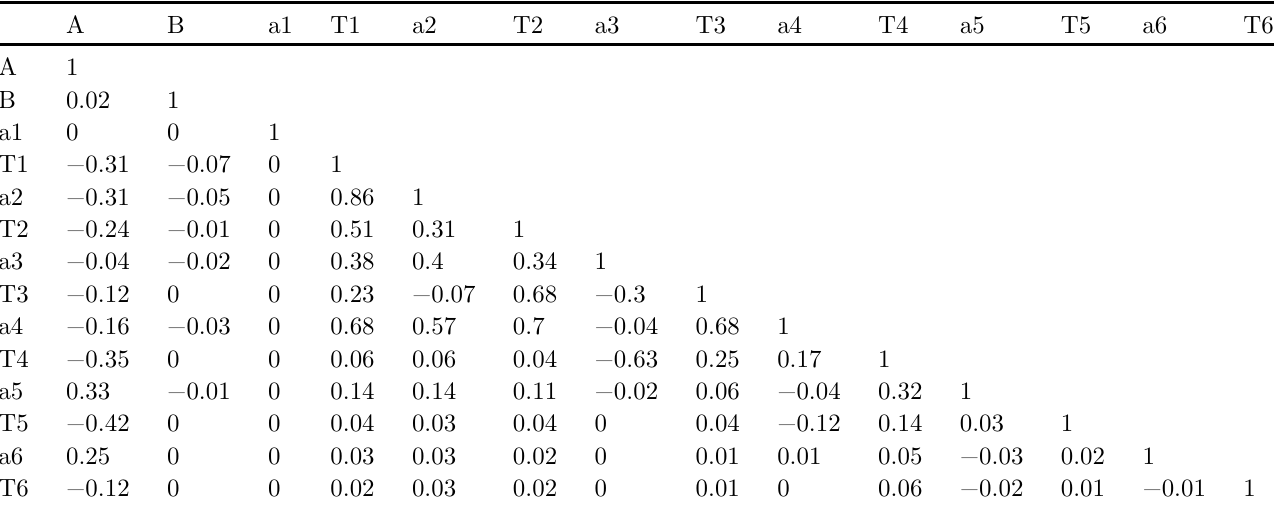
Table 10. The 6-group correlation matrix obtained in processing of the experimental decay curve measured from fi ssion of 235 U by thermal